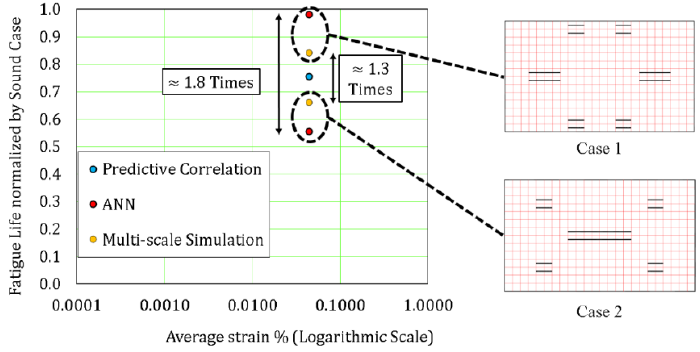
Figure 20. Comparison of the remaining fatigue life between two crack patterns of the same cracks density.